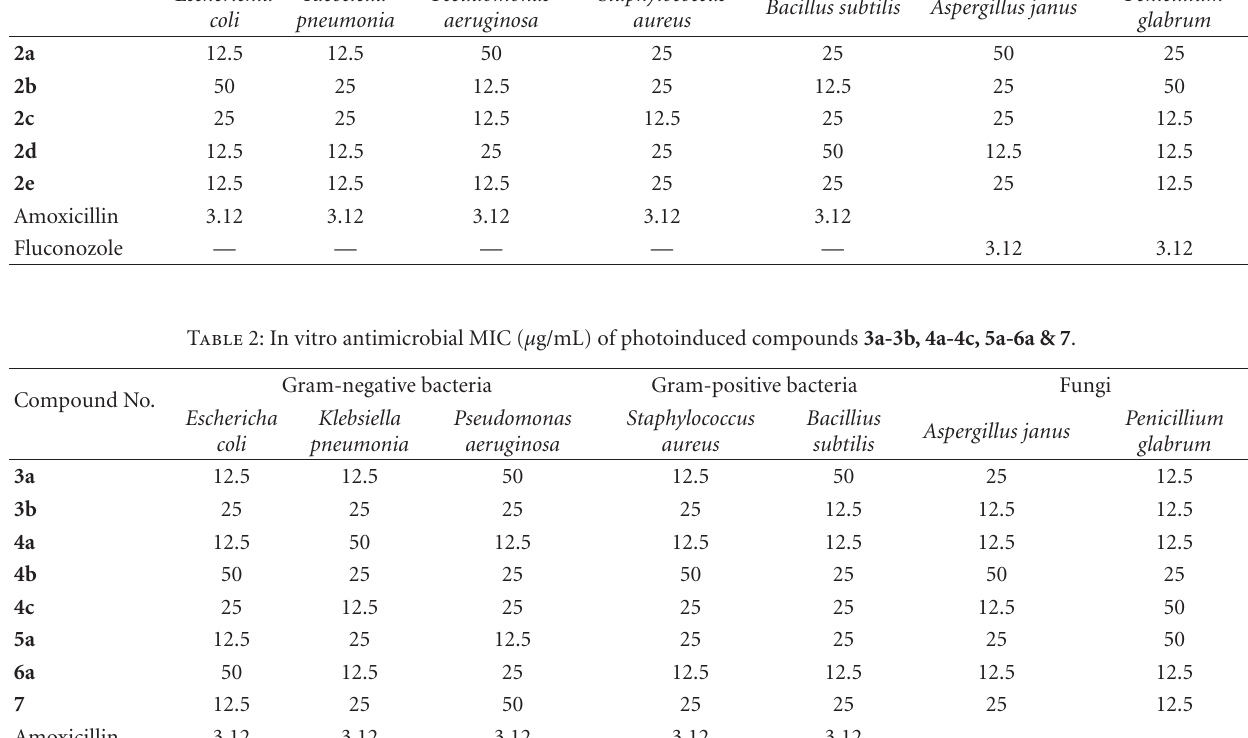
Table 1: In vitro antimicrobial MIC ( μ g/mL) of compounds 2a-2b . Compound No.